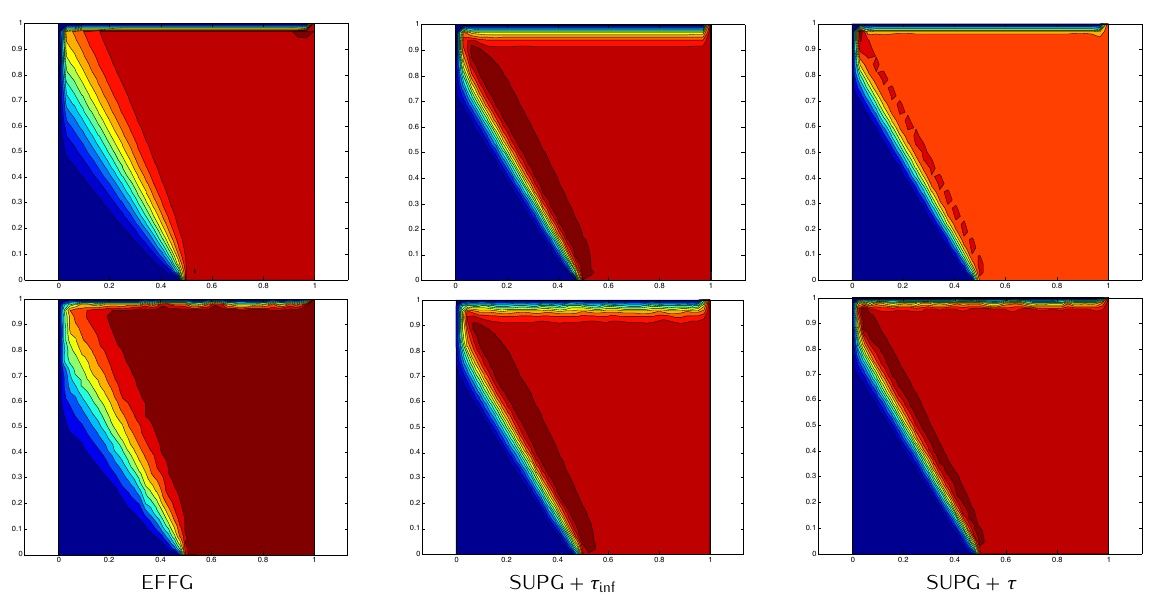
Figure 6. Solution of the skew advection test problem (30) with ε = 0 . 00001 by EFFG (left) vs. SUPG with τ inf (center) and SUPG with τ (right) on 33 × 33 grids. Top row: uniform grid. Bottom row: randomly perturbed grid.